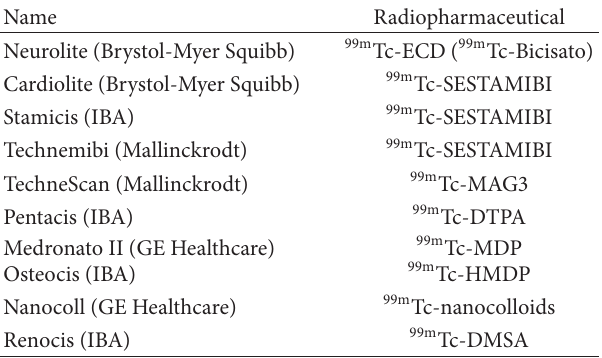
Table 1: Radiopharmaceuticals used in the study.